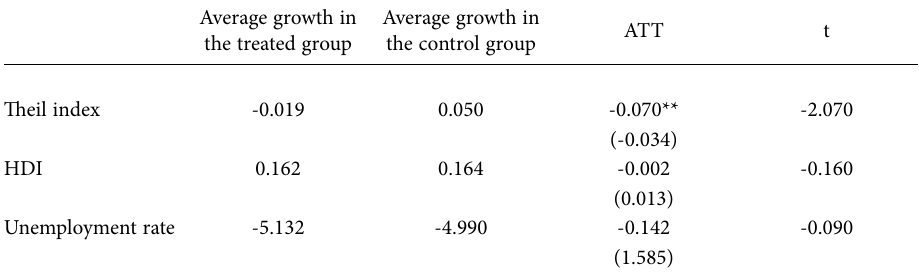
Table 4. Average Treatment Effect on the Treated (ATT) of growing grape, 2000-2010. Average growth in Average growth in ATT the treated group the control group